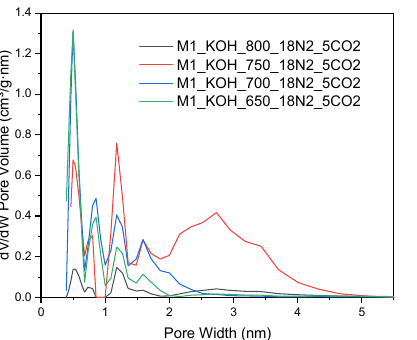
Figure 1. The adsorption ‐ desorption isotherms of N 2 for activated carbons.